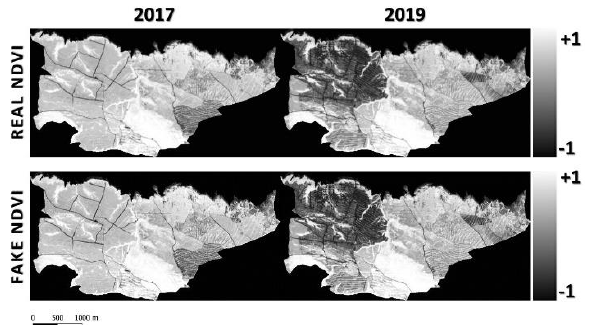
Figure 7. NDVI and image-to-image translated fake NDVI using Cycle-GAN.